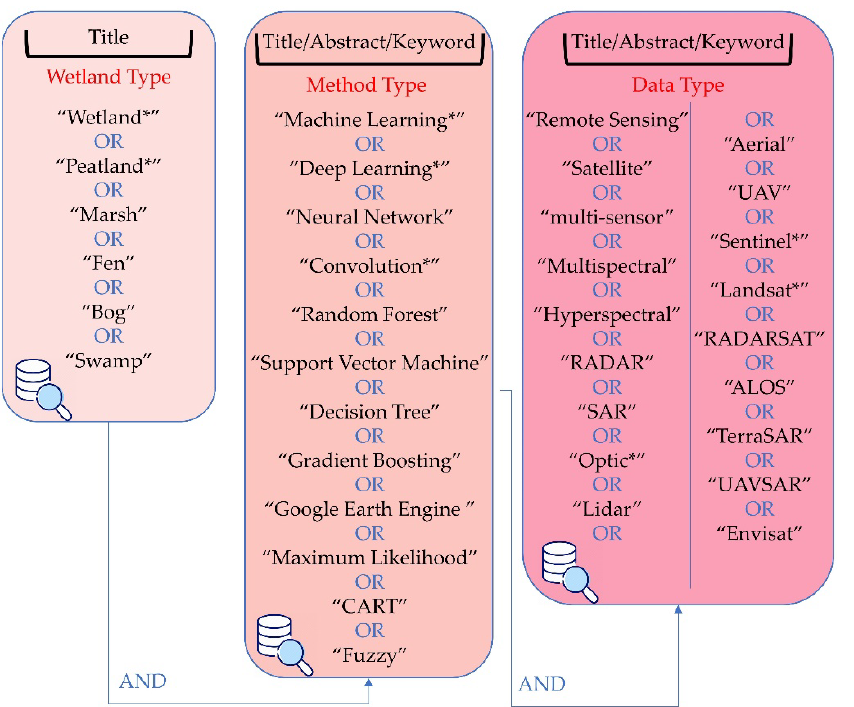
Figure 2. The predefined search query and list of keywords to prepare the procurements of this meta-analysis.